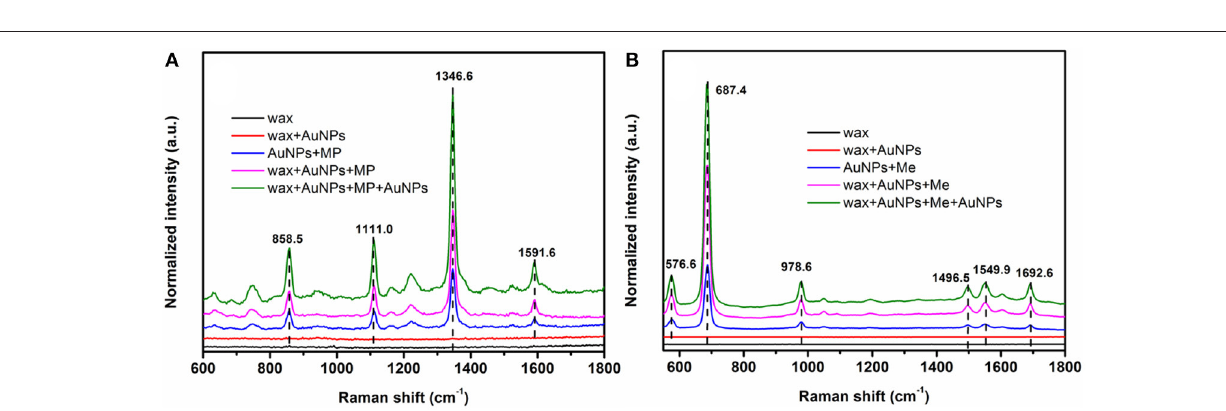
FIGURE 5 | (A) Raman scattering spectra of wax (black), wax coated with 60nm AuNPs (red), mixture of methyl parathion (10 − 4 M) and 60nm AuNPs deposited on silicon wafer (blue), methyl parathion (10 − 4 M) and AuNPs deposited on wax-coated silicon wafer (pink), and methyl parathion (10 − 4 M) and AuNPs deposited on wax-coated silicon wafer with an additional layer of AuNPs (green). (B) Raman scattering spectra of wax (black), wax coated with 130nm AuNPs (red), mixture of melamine (10 − 5 M) and 130nm AuNPs deposited on silicon wafer (blue), melamine (10 − 5 M) and AuNPs deposited on wax-coated silicon wafer (pink), and melamine (10 − 5 M) and AuNPs deposited on wax-coated silicon wafer with an additional layer of AuNPs